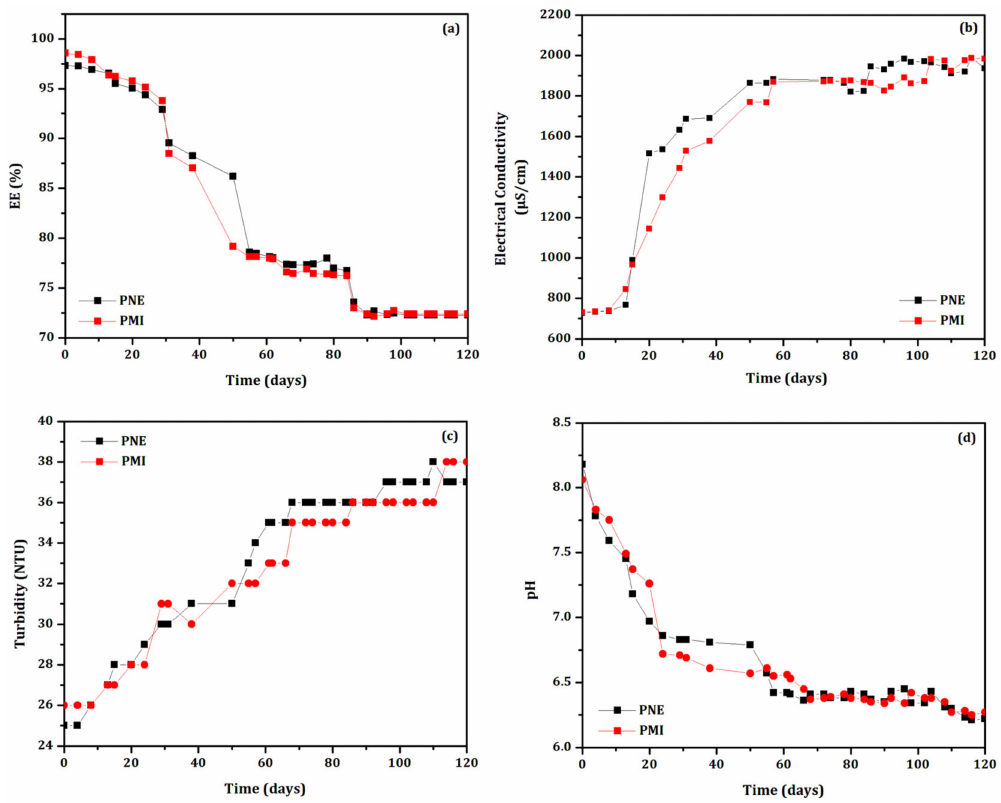
Figure 2. Evaluation of ( a ) EE%, ( b ) electrical conductivity, ( c ) turbidity, and ( d ) pH of the biodefen- sives PNE (black curves) and PMI (red curves) maintained under constant handling at (35 ± 2) ◦ C for 30